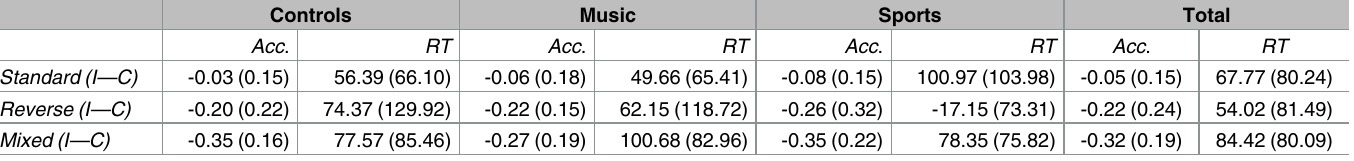
Table 4. Mean accuracyand response time during the three conditions of the Flanker Fish